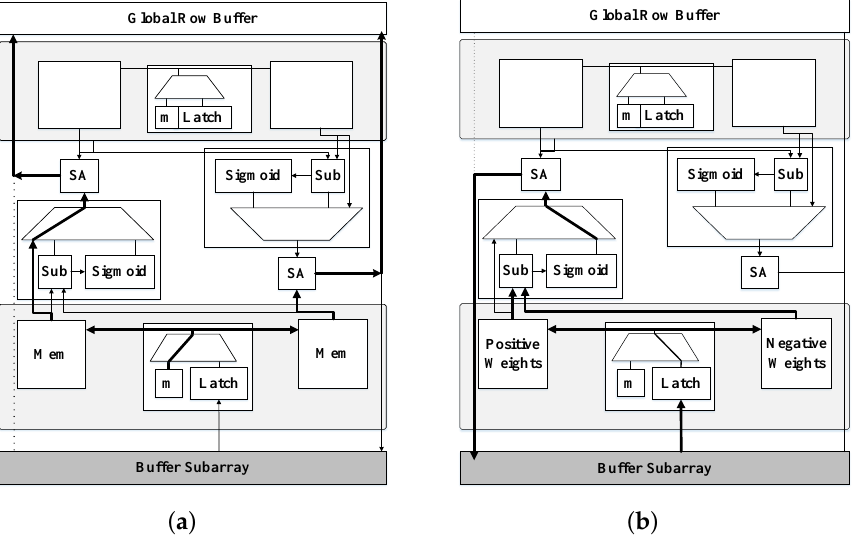
Figure 18. PRIME FF subarray configurations (adapted from [52]). ( a ) Memory mode; ( b ) Computa- tion mode.